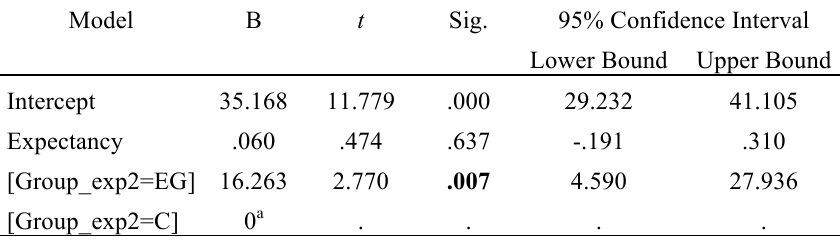
Differences between groups A and B in the Index of CL use Model B t Sig. Intercept